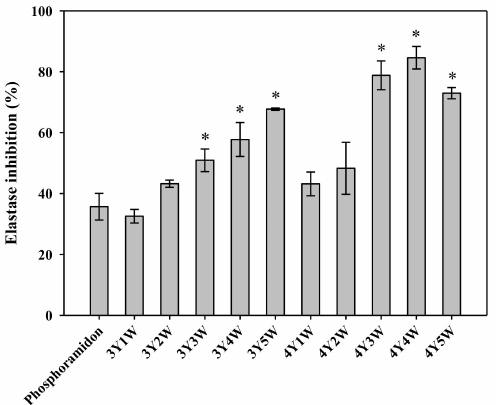
Figure 4. Elastase inhibitory activities of ginseng berry extracts harvested at various time points. Rectangular bars and their error bars represent means and standard deviations, respectively ( n =